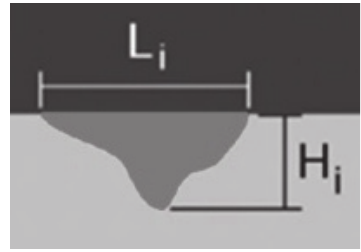
Figure 1: Image analysis of a corrosion